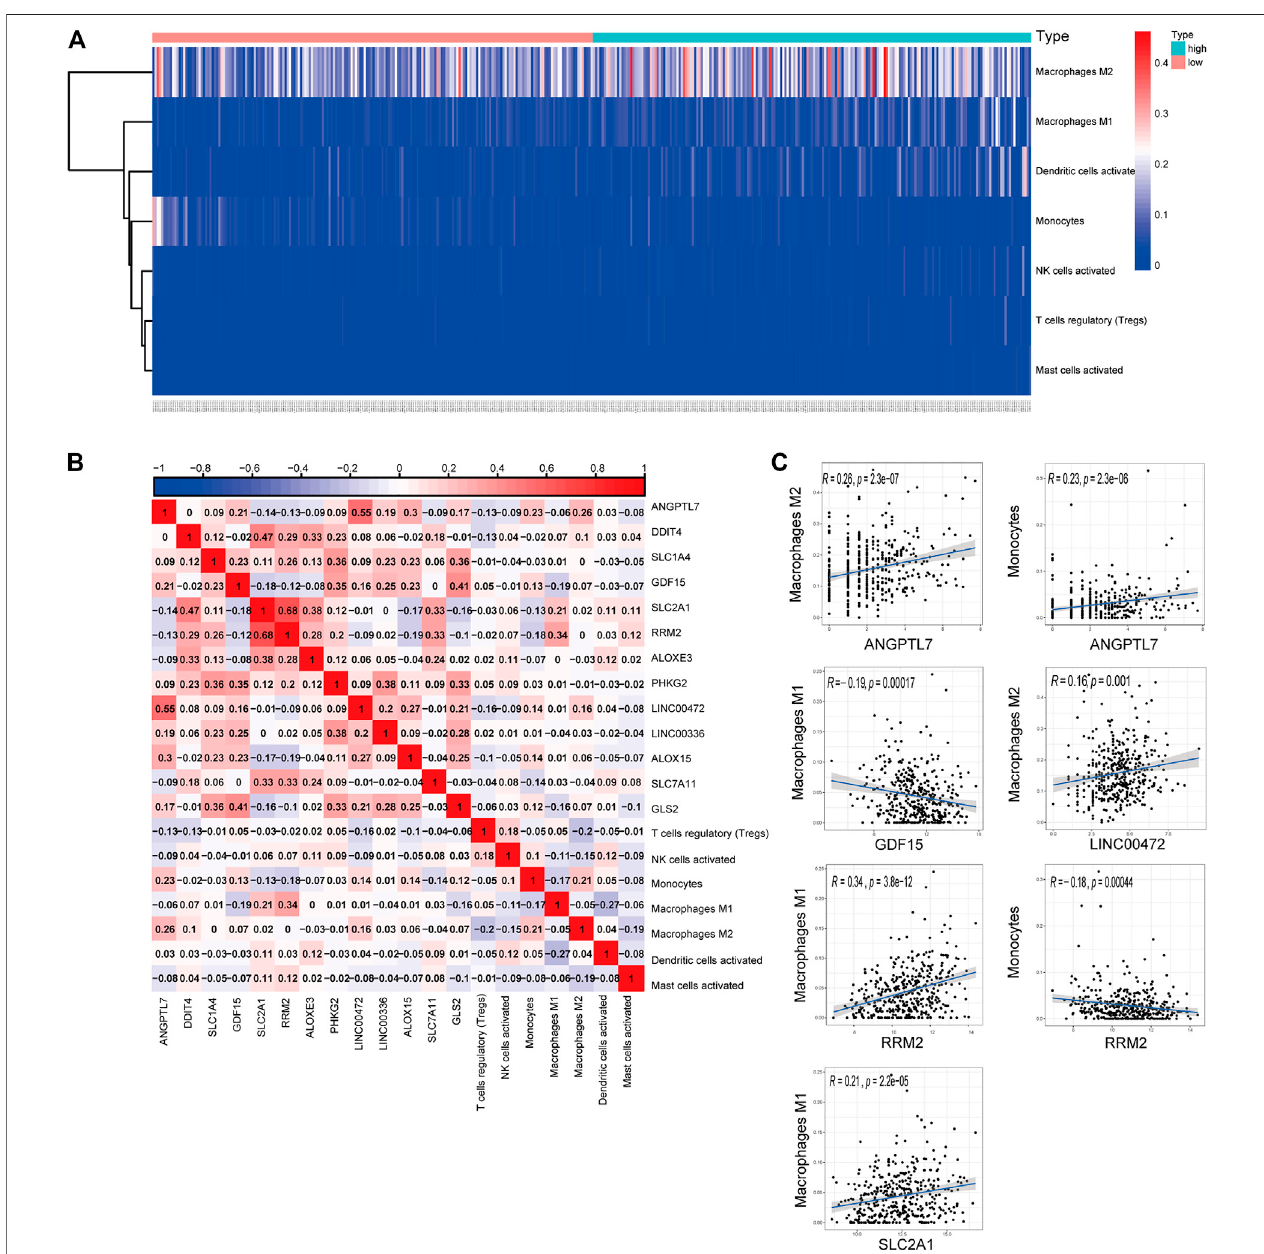
FIGURE6|(A) Theriskheatmapofsigni fi cantin fi ltratingimmunecells. (B) Theresultoftheco-expressionanalysisbetweentumor-in fi ltratingimmunecellsandthe ferroptosis-related genes signature. (C) ANGPTL7 and M2 macrophages (R (cid:1) 0.26, p < 0.001), ANGPTL7 and monocytes (R (cid:1) 0.23, p < 0.001), GDF15 and M1 macrophages (R (cid:1)− 0.19, p < 0.001),LINC00472and M2 acrophages (R (cid:1) 0.16, p (cid:1) 0.001), RRM2 and M1 macrophages (R (cid:1) 0.34, p < 0.001),RRM2 and monocytes (R (cid:1)− 0.18, p < 0.001),andSLC2A1andM1macrophages(R (cid:1) 0.21, p < 0.001),andtheseremindedustherelationshipbetweentheferroptosis-relatedgenesand tumor-in fi ltrating immune